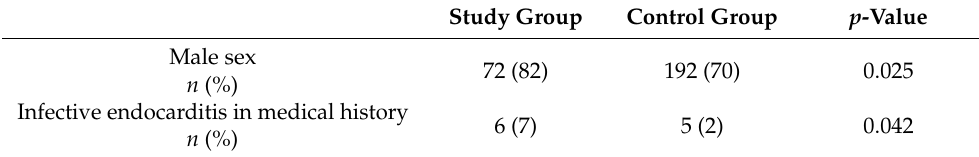
Table 5. Factors predisposing to the occurrence of isolated SVT.